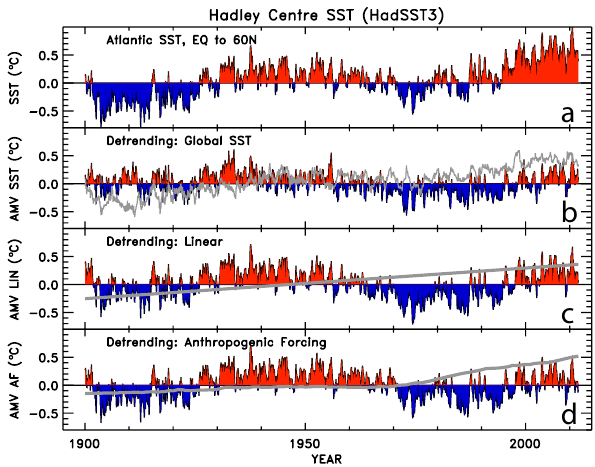
Fig. 5. (a) Area weighted, monthly mean SST in the North At- lantic (equator to 60 ◦ N) based on HadSST3 data. (b) AMV index (blue and red) found by detrending North Atlantic SST using area weighted SST between 60 ◦ S and 60 ◦ N (gray curve). (c) AMV in- dex (blue and red) found by calculated by detrending North Atlantic SST using a linear regression (gray line). (d) AMV index (blue and red) found by detrending North Atlantic SST using anthropogenic RF of climate (gray line). The particular anthropogenic RF curve is an MLR simulation constrained to match the CRU4 global temper- ature record, NAA RF 2005 = − 1 . 0Wm − 2 along the Middle Road, and OHC from Church et al.